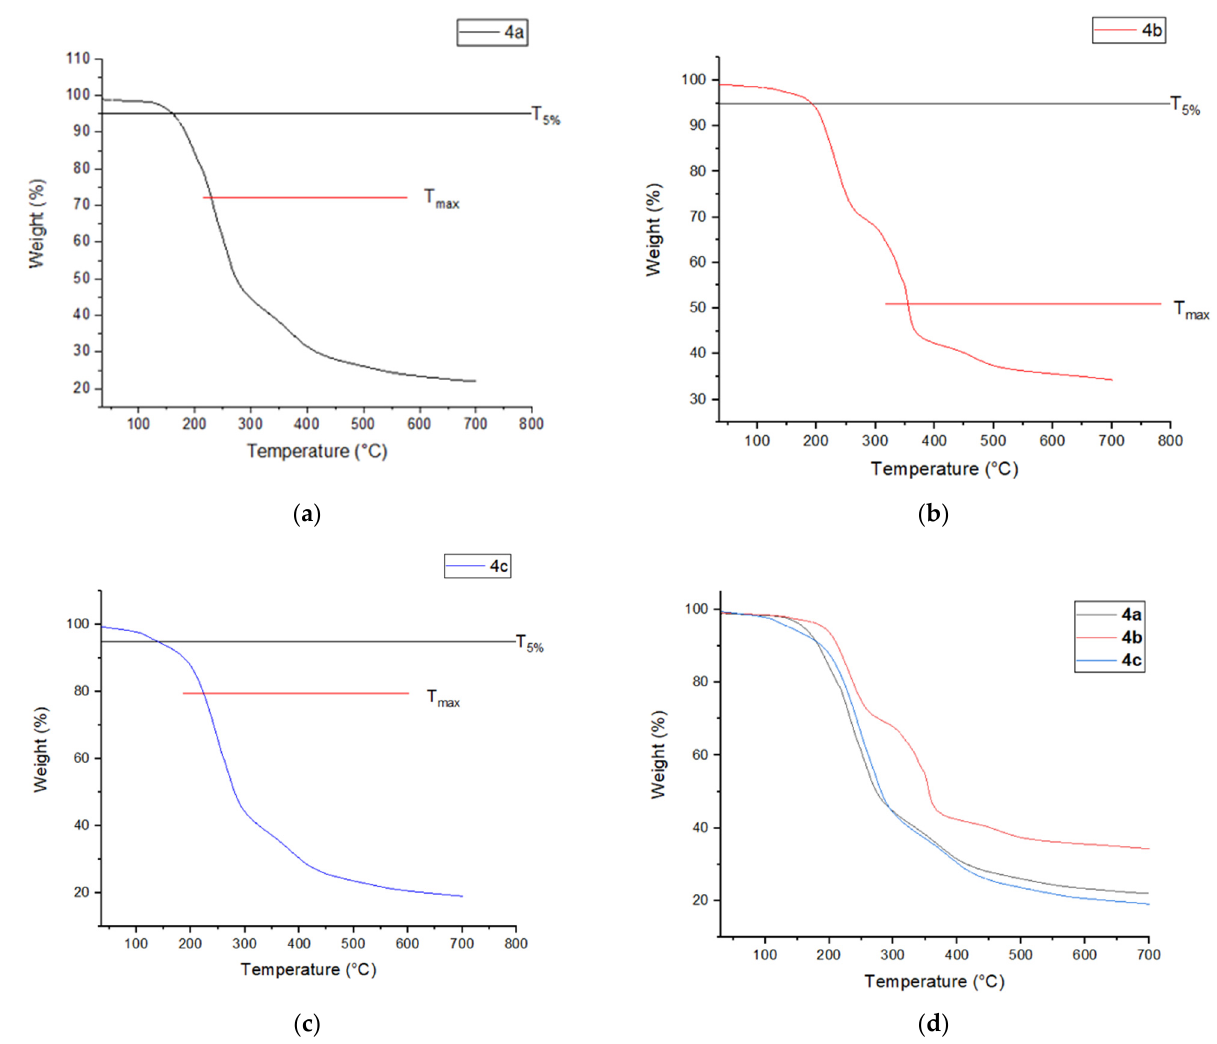
Figure 6. TGA curves for ( a ) compound 4a , ( b ) compound 4b , ( c ) compound 4c and ( d ) all the final compounds containing electron withdrawing group as terminal end from 50 to 700 °C at a heating rate of 10 °C/min under N 2 flow of 30 mL/min. Table 2. Thermal properties of final compounds, 4a–c . Compounds